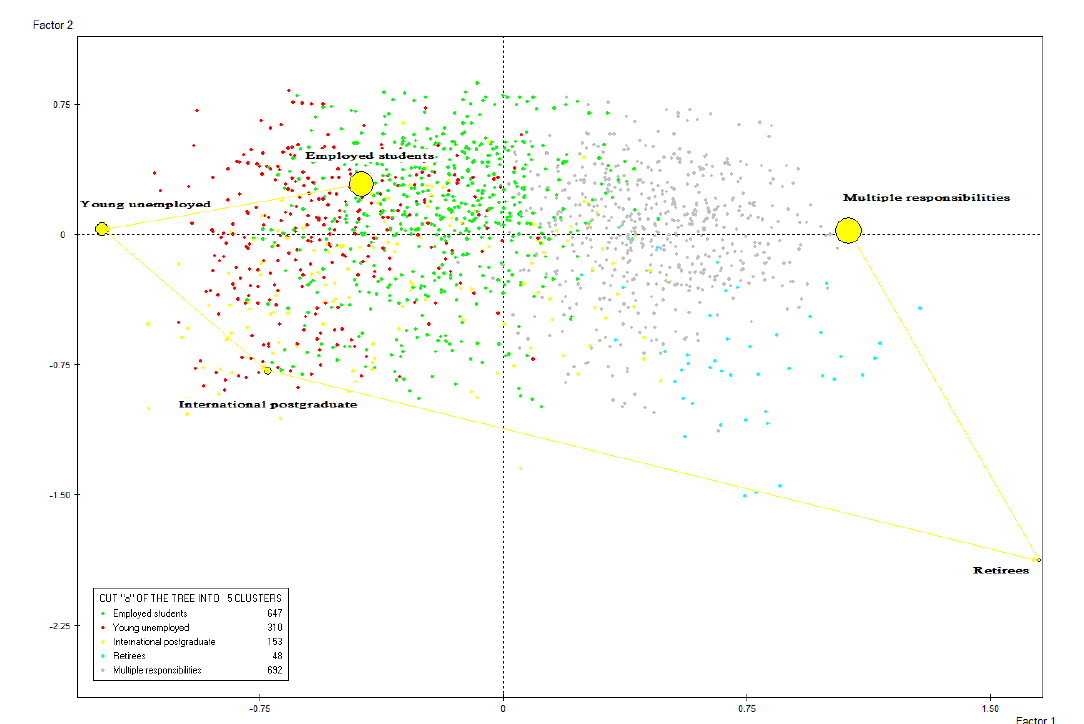
Figure 3. Student typology by social